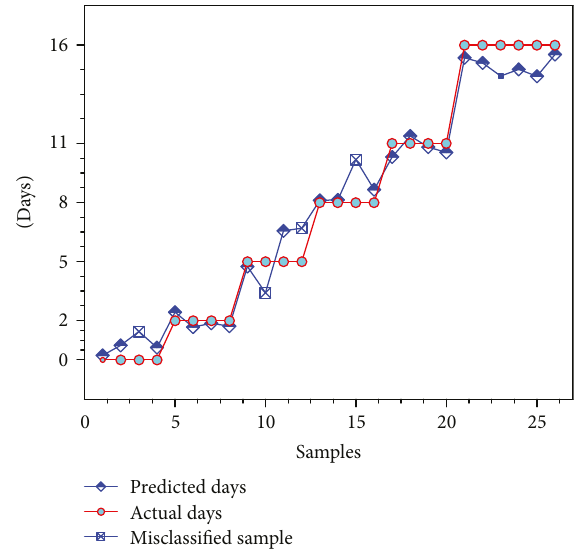
Figure 7: The predicted results of BP-NN model for test sets of the salmon